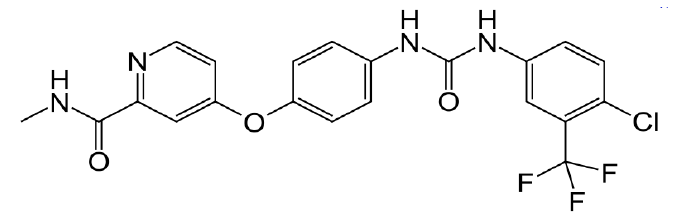
Figure 1. Chemical structure of